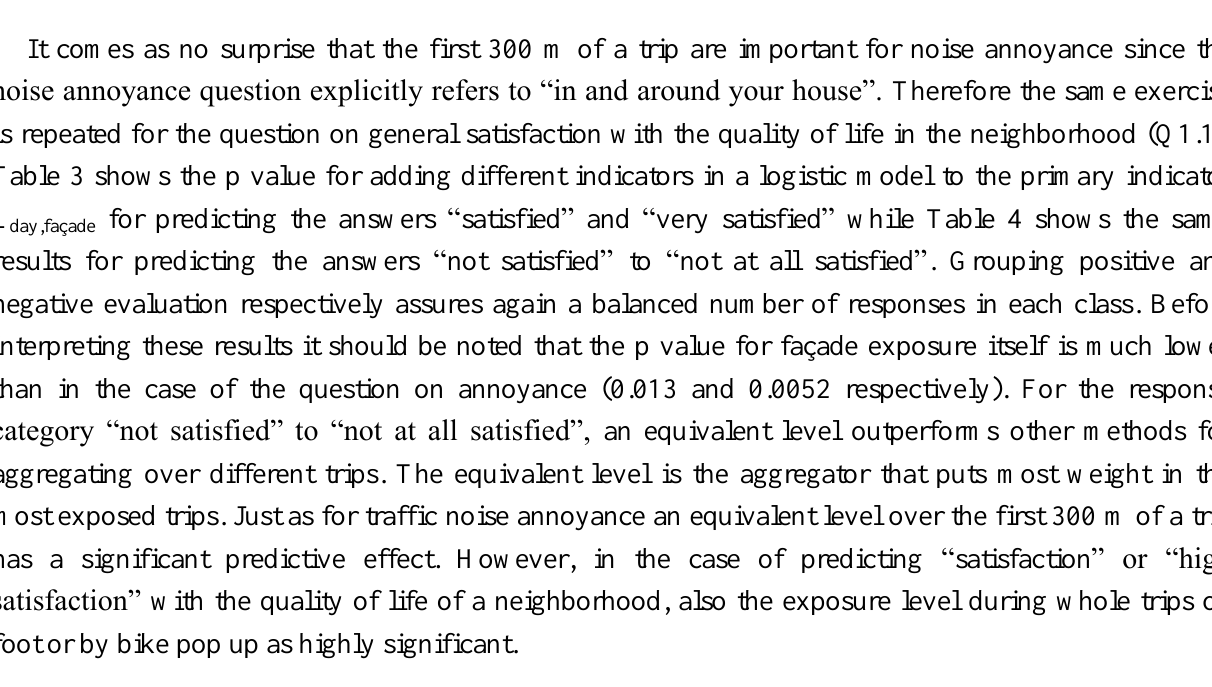
Table 2. p in chi square test for a logistic model predicting moderate, high or extreme traffic noise annoyance (Q2.1a) on the basis on L additional indicator in the table. The value of p for L